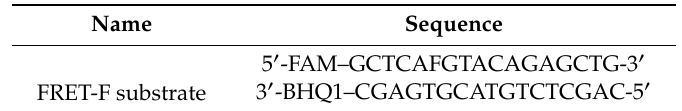
Table 1. The sequence of the DNA substrate used in the F site cleavage assay of WT APE1 and its SNP variants in the presence of BER proteins.